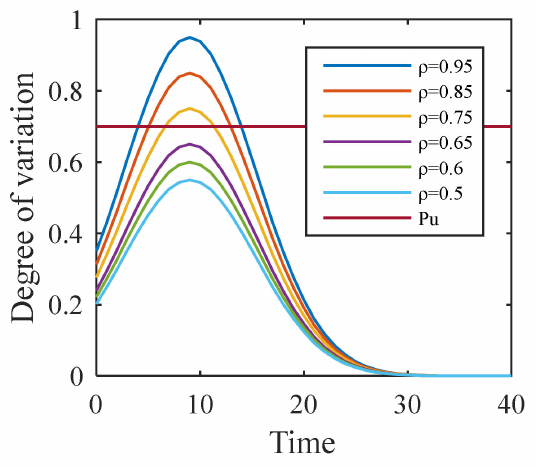
Figure 6. The changes of degree of variation under different information alienation